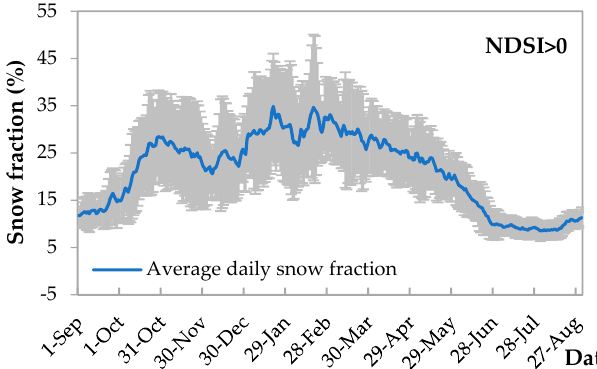
Figure 11. The average daily snow fraction over the TP during 2001–2017. Note: the gray error bars represent the standard deviation.